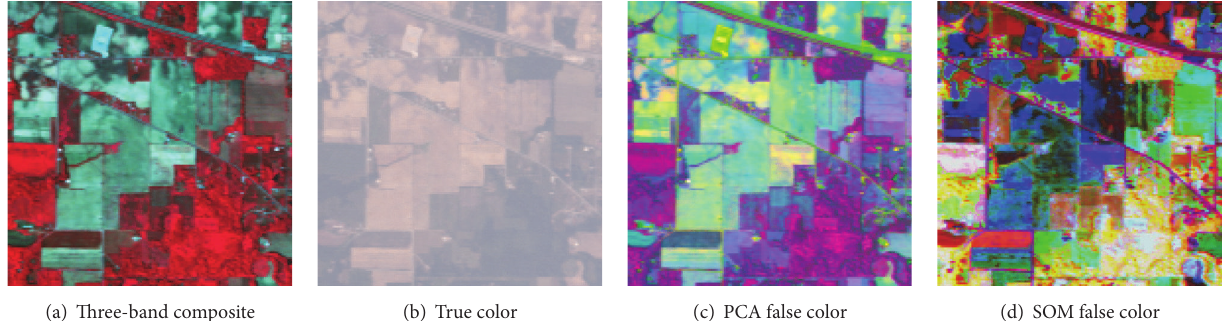
Figure 9: Color visualizations of Indian Pines image. SOM visualization is more feature-rich when compared to